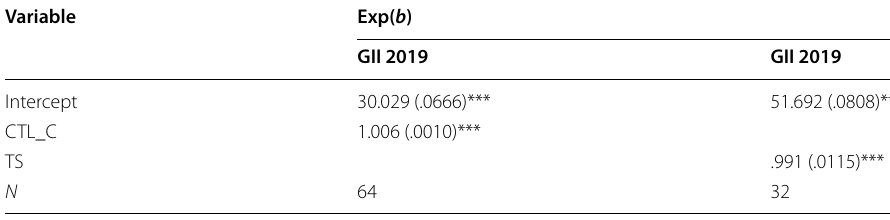
Table 5 Regression data Uz and